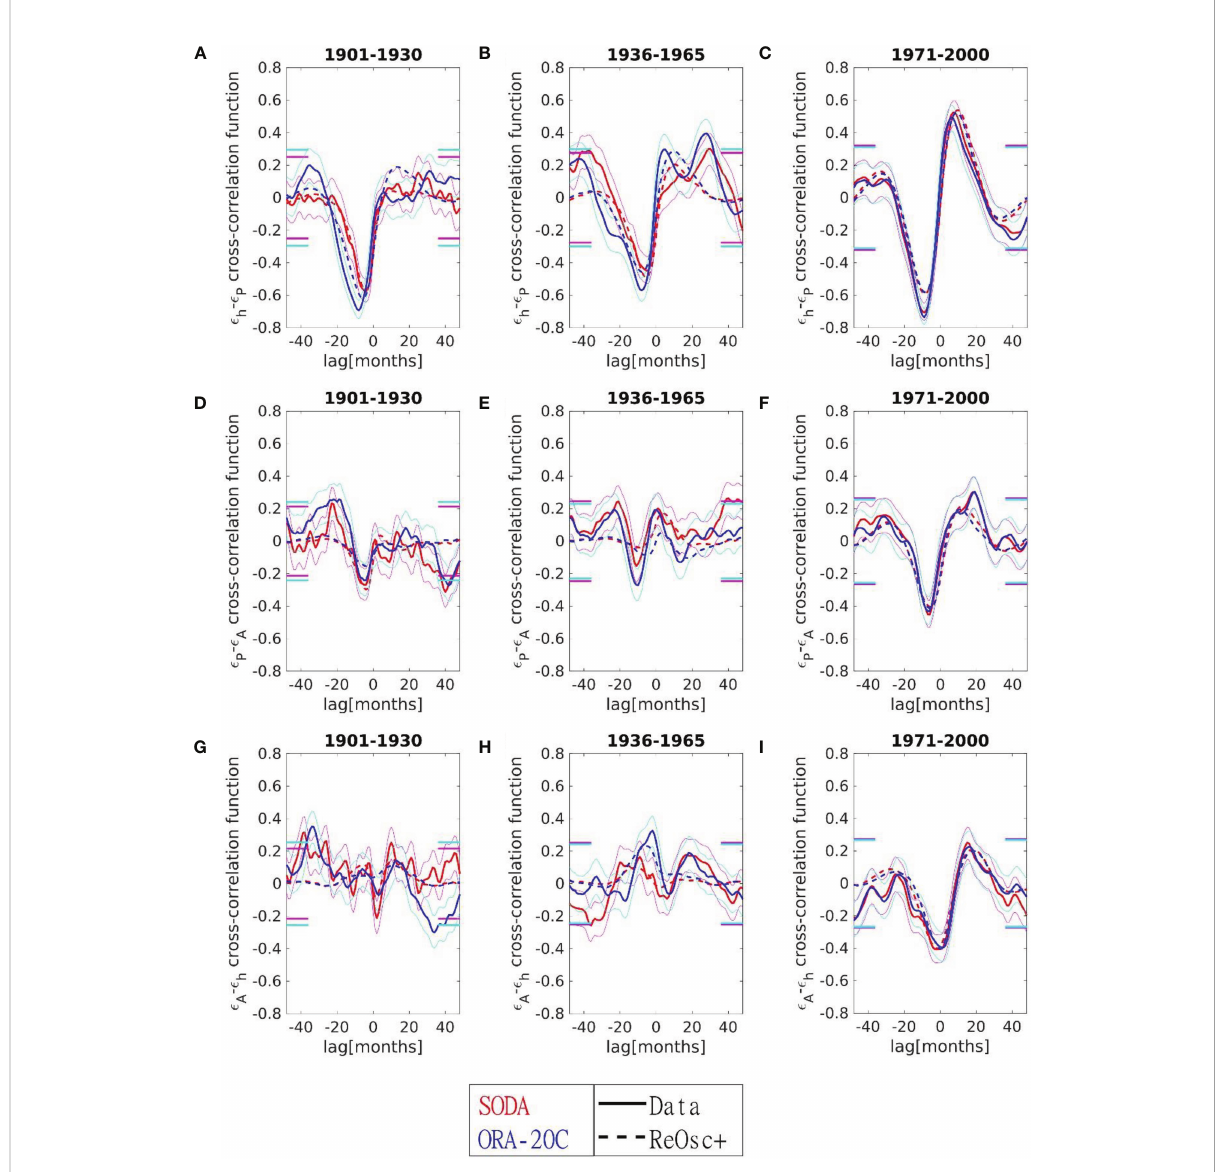
FIGURE 9 Normalized cross-correlation functions c N hP (for the periods 1901-1930 (A) , 1936-1965 (B) , and 1971-2000 (C) ), c N PA (for the periods 1901-1930 (D) , 1936-1965 (E) , and 1971-2000 (F) ), and c N Ah (for the periods 1901-1930 (G) , 1936-1965 (H) , and 1971-2000 (I) ), both for SODA (solid red line) and ORA-20C (solid blue line, mean of all members) data, and ReOsc+ model (dashed line) for the three-variable Paci fi c-Atlantic dynamics (Eq. 1 fi tted as explained in Section 2.3). Magenta (for SODA) and cyan (for ORA-20C) thin lines show the con fi dence interval of the crosscorrelation, obtained by a Fisher ’ s Z transform at 95% con fi dence (see Supplementary Appendixes A, D). Magenta (for SODA) and cyan (mean of all members for ORA-20C) thick lines show the uncertainty in uncorrelation beyond 36 months, i.e., solid lines inside those limits indicate that there are no signi fi cant contributions from the correlations beyond 36 months (see Supplementary Appendix